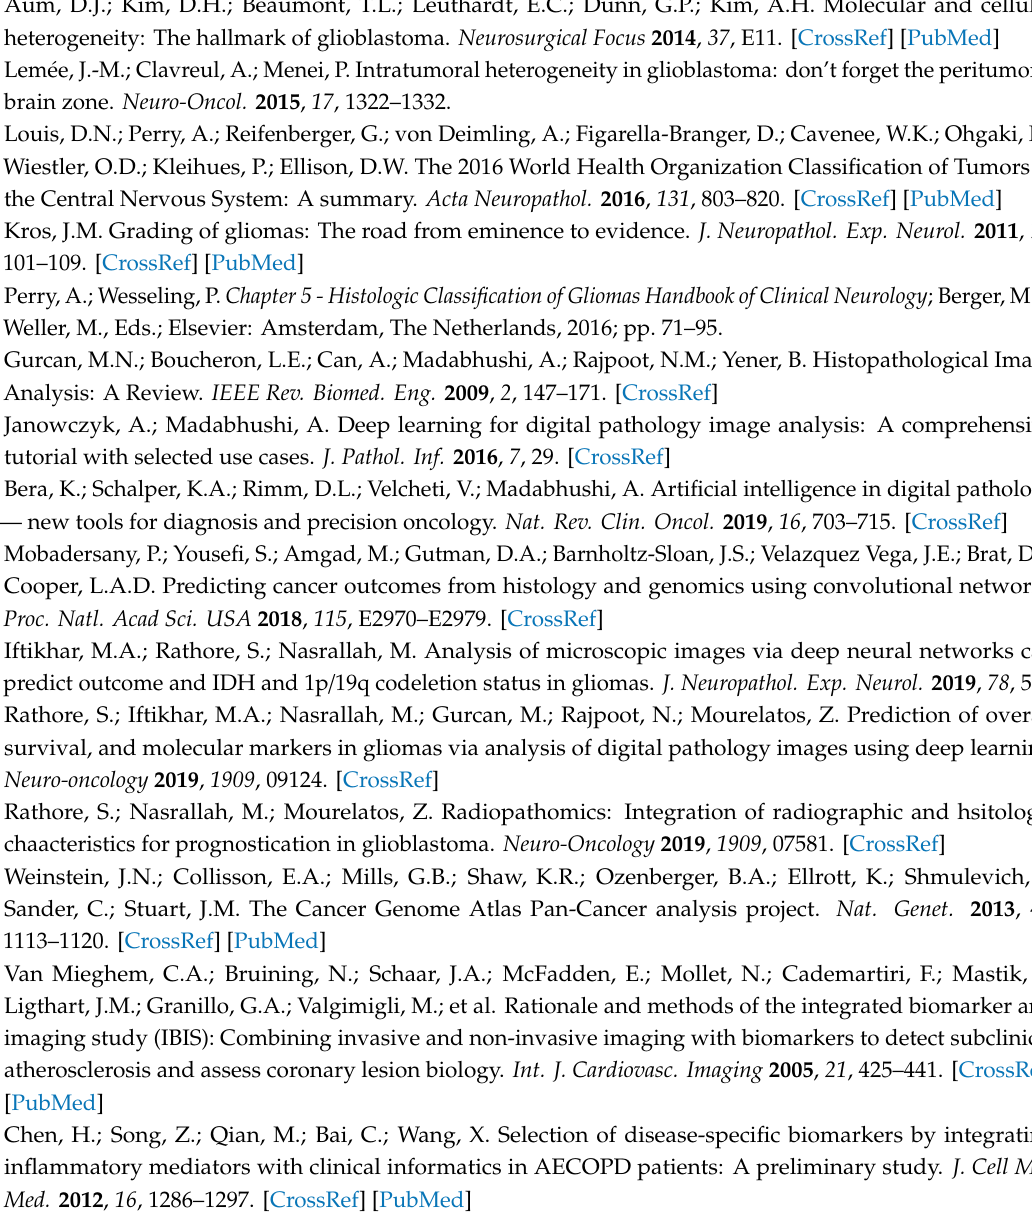
Table S1: Dataset used in the study, Table S2: E ff ect sizes of the discriminatory